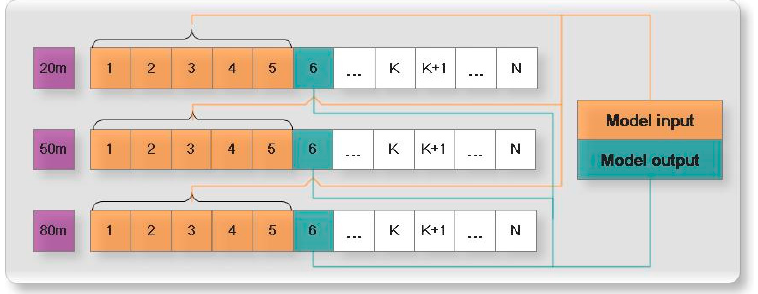
Figure 5. The input and output of the ELM–Elman–LSTM model.